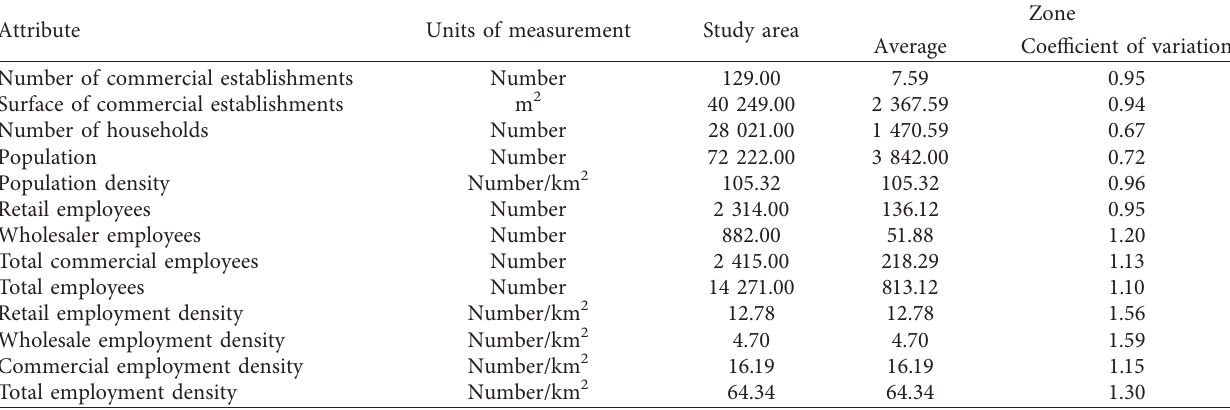
Table 2: Aggregated data on socioeconomic attributes (for model calibration).